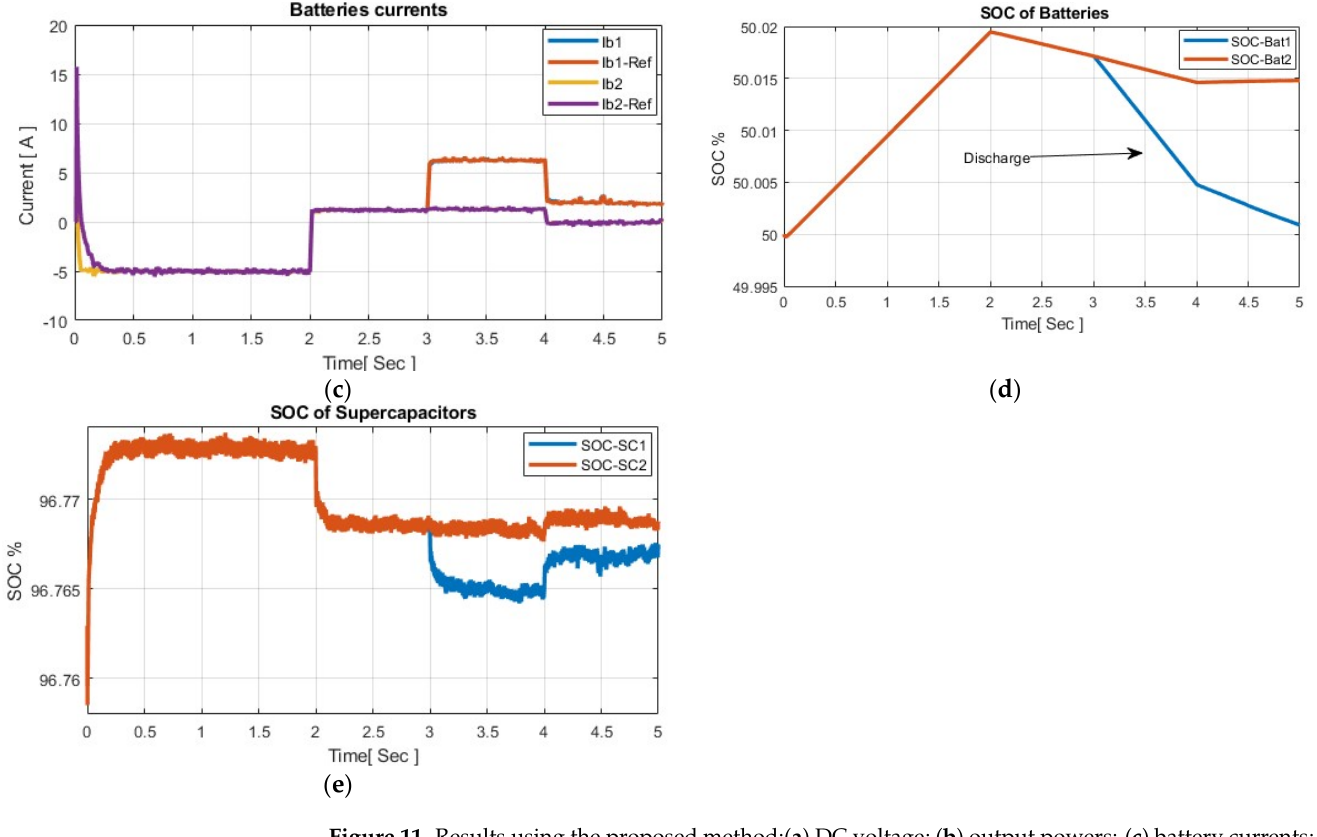
Figure 11. Results using the proposed method:( a ) DC voltage; ( b ) output powers: ( c ) battery currents; ( d ) SOCs of batteries; ( e ) SOC of SCs.